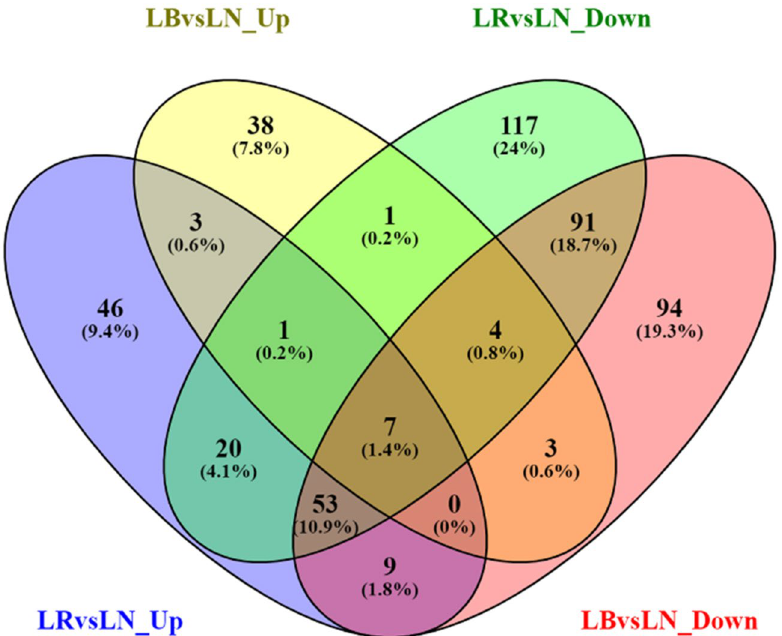
Figure 4. The number of shared and unique biological processes across different light treatments. LB: Blue light; LR: Red light; LN: white